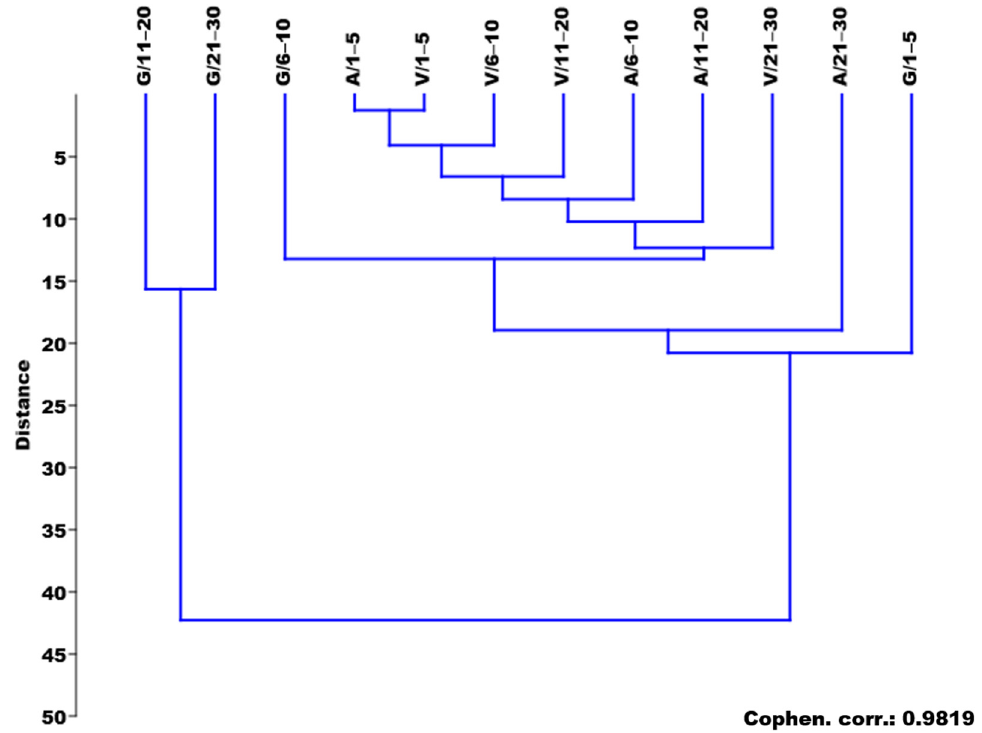
Figure 9. Results of the hierarchical cluster analysis of forest steppe species in different age groups of abandoned lands (V—vineyards, A—arable land, G—grasslands). abandoned lands (V—vineyards, A—arable land,